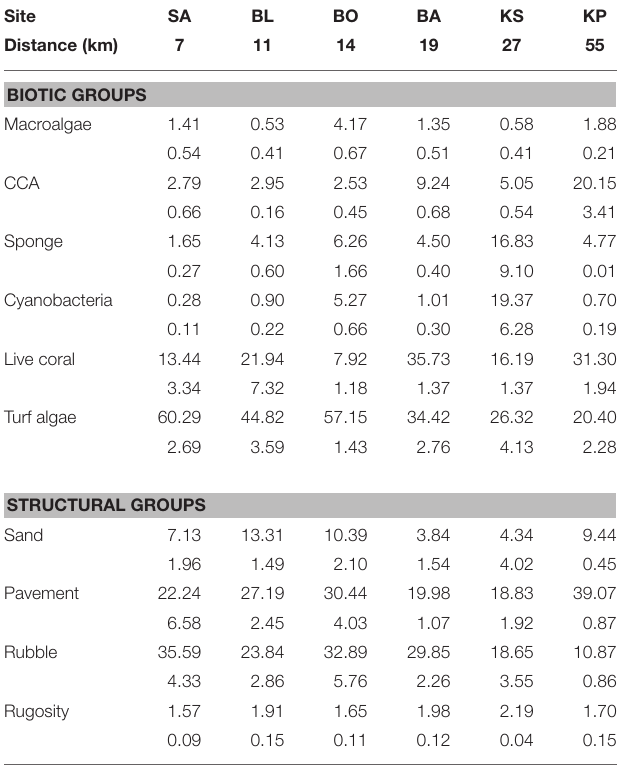
TABLE 1 | Mean percentage benthic cover ( ± SE below) of primary biotic and structural groups, and rugosity. Site